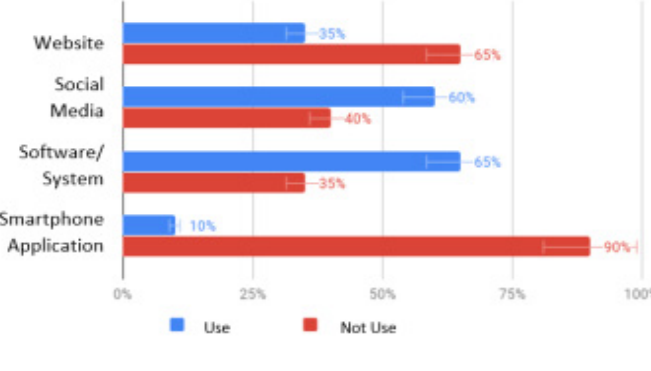
Figure 3: Use of Digital Media in Cooperative Source: Primary Data,